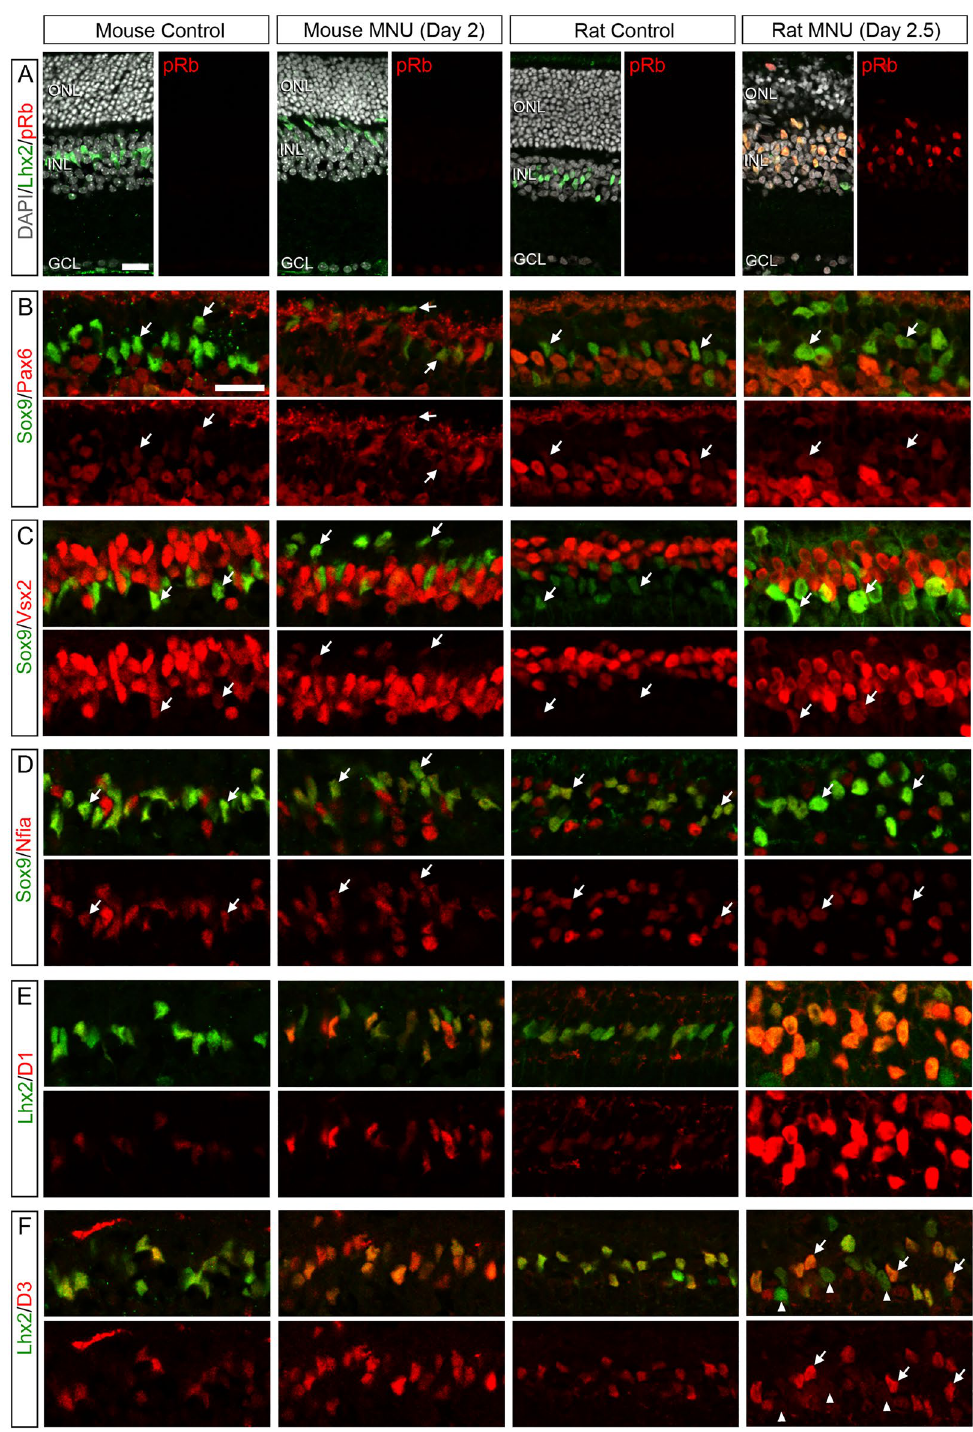
Figure 2. Immunofluorescence for RPC transcription factors and cell cycle regulators in Müller glia after MNU-induced injury in mice and rats. ( A ) Phospho-pRb (pRb) immunoreactivity in Lhx2 + Müller glia. ( B ) Pax6 immunoreactivity in Sox9 + Müller glia (arrows). ( C ) Vsx2 immunoreactivity in Sox9 + Müller glia (arrows). ( D ) Nfia immunoreactivity in Sox9 + Müller glia (arrows). ( E ) Cyclin D1 immunoreactivity in Lhx2 + Müller glia (arrows). ( F ) Cyclin D3 immunoreactivity in Lhx2 + Müller glia. Some Müller glia were intensely labeled for cyclin D3 (arrows) while others were negative or only weakly positive (arrowheads) in the rat retina after injury. ONL outer nuclear layer, INL inner nuclear layer, GCL ganglion cell layer. Scale bar = 20